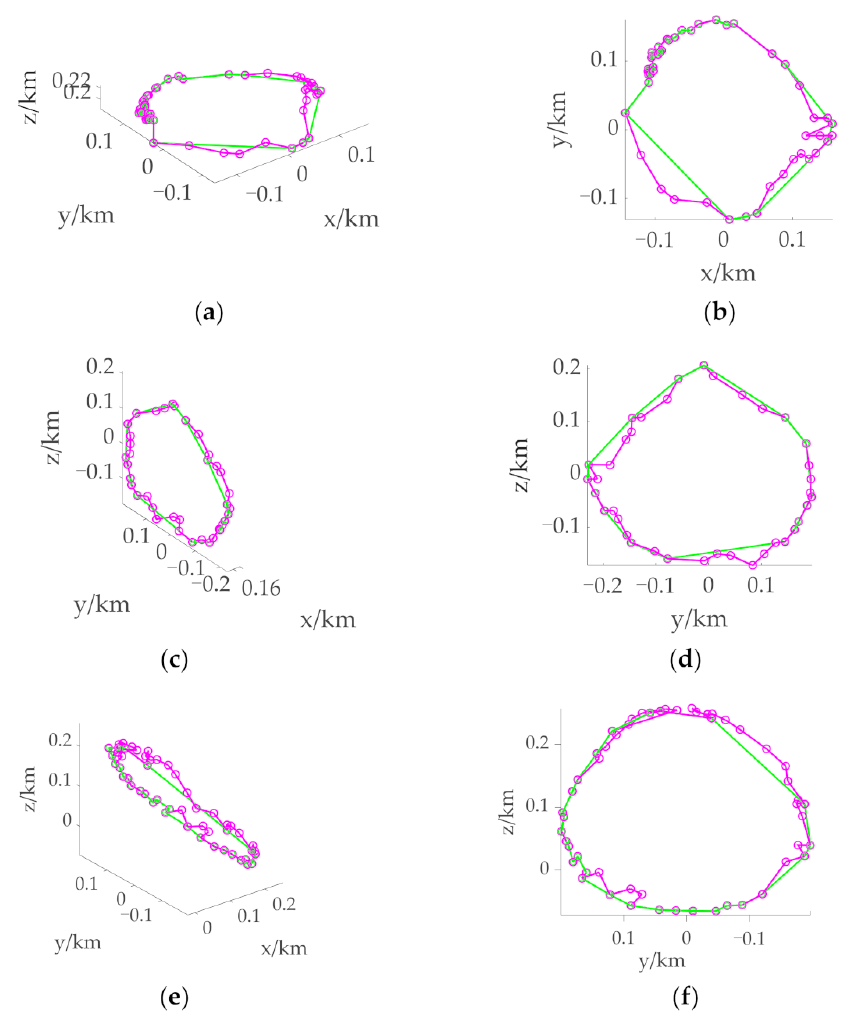
Figure 7. Boundary of the reachable domain under different initial states with t f = 700 s. ( a ) 3D view of the boundary when the initial position is over the North Pole. ( b ) Supplementary view of the boundary when the initial position is over the North Pole. ( c ) 3D view of the boundary when the initial position is over the Equator. ( d ) Supplementary view of the boundary when the initial position is over the Equator. ( e ) 3D view of the boundary when the initial position is over the mid-latitude region. ( f ) Supplementary view of the boundary when the initial position is over the mid-latitude region. The green connecting line stands for the initial boundary. The purple connecting line stands for the continuous